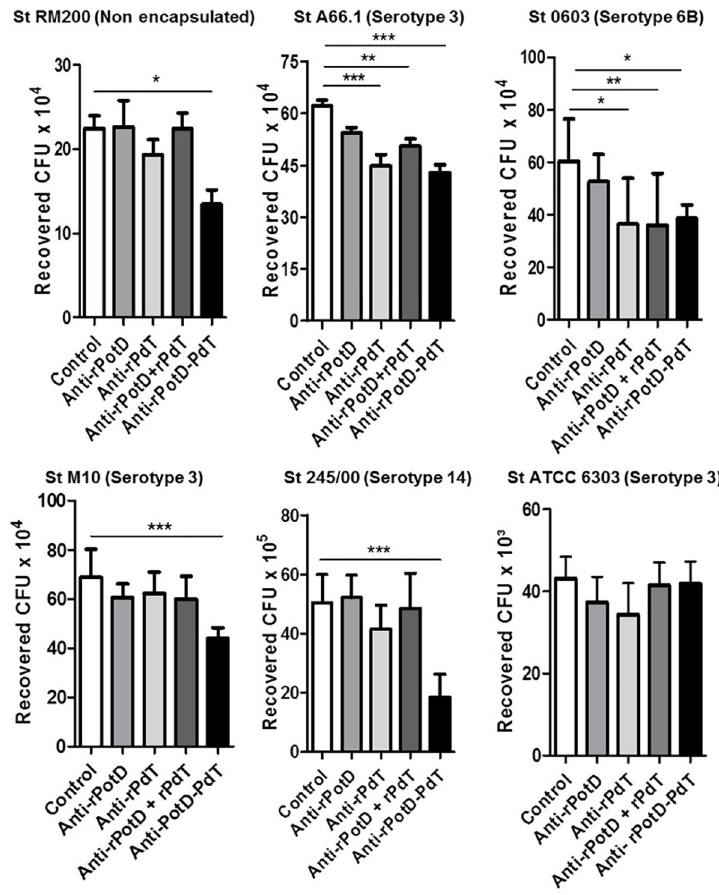
Fig 5. Pneumococcal phagocytosis mediated by specific antibodies in the presence of complement. Pneumococcal strains St RM200, St A66.1, St 0603, St M10, St 245/00 and St ATCC6303 were incubated with antisera from mice immunized with rPotD, rPdT, rPotD + rPdT or rPotD-PdT and NMS as complement source, followed by incubation with mouse peritoneal phagocytes and plated on blood agar plates. CFU recovered were counted after 18 h. � p < 0.05; �� p < 0.01; ��� p < 0.001 for treated versus control or between immunized groups, as indicated. The values correspond to mean + SD of three independent experiments.